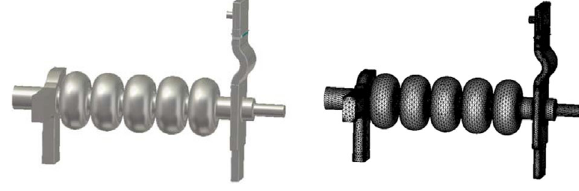
FIG. 17. The rf model (left) and mesh representation (right) for simulating a C75 cavity in a VTA cavity-pair